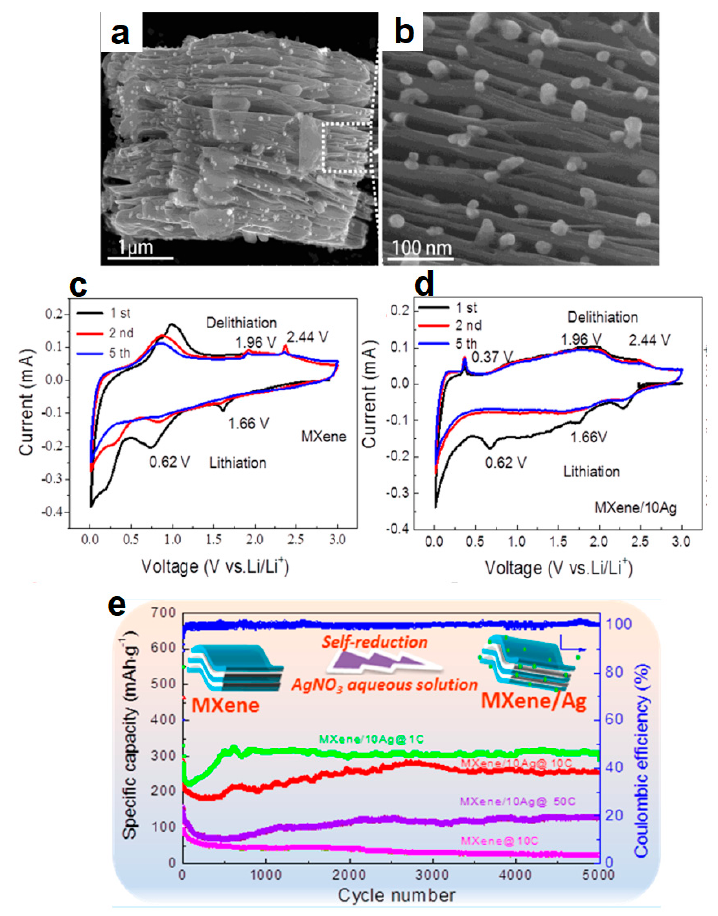
Figure 7. ( a , b ) SEM images of Ti 3 AlC 2 /Ag composites; ( c , d ) Cyclic voltammograms of Ti 3 C 2 and of Ti 3 C 2 /Ag composites; ( e ) Specific capacity vs cycle number and coulombic efficiency of Ti 3 AlC 2 /Ag composite. Reprinted with permission from [53]. Copyright © 2016, American Chemical Society.